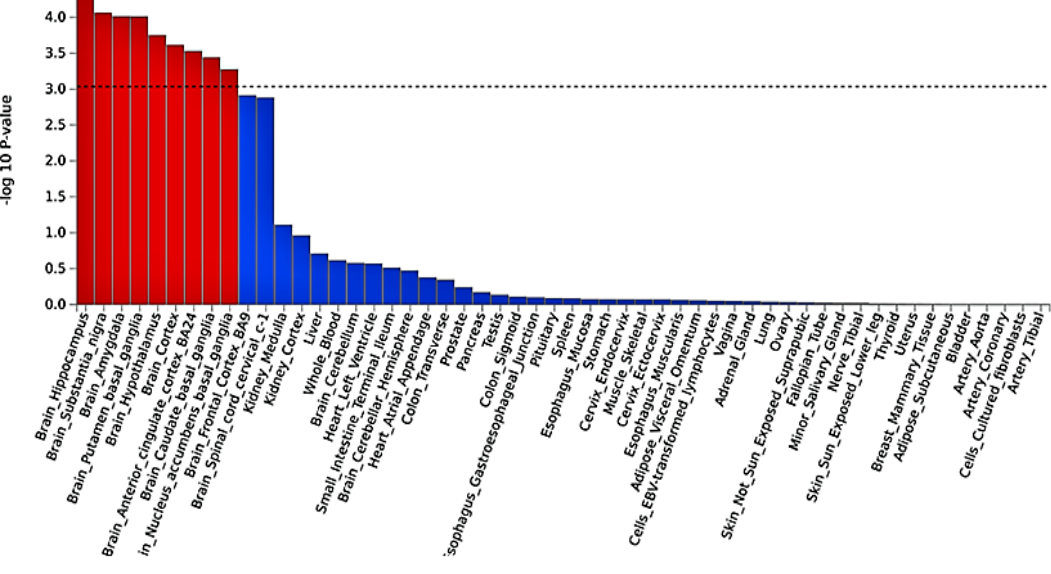
Figure 3. MAGMA tissue expression analysis using gene expression per tissue based on GTEx RNAseq data for 53 specific tissue types. Significant tissue is shown in red.